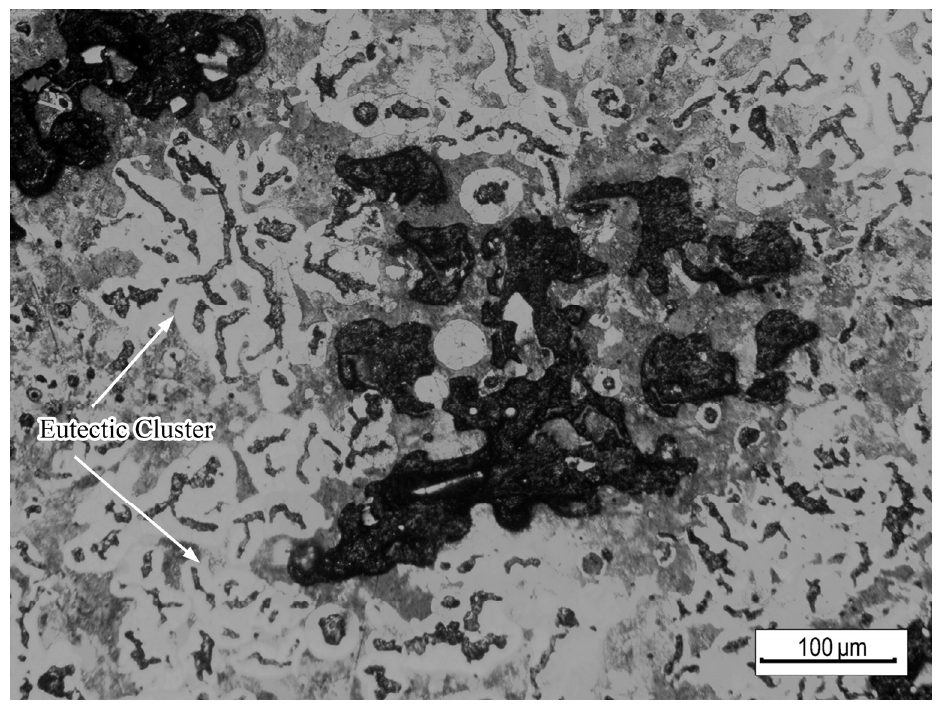
Figure 8. Optical metallographic microstructure around the shrinkage in compacted graphite iron.